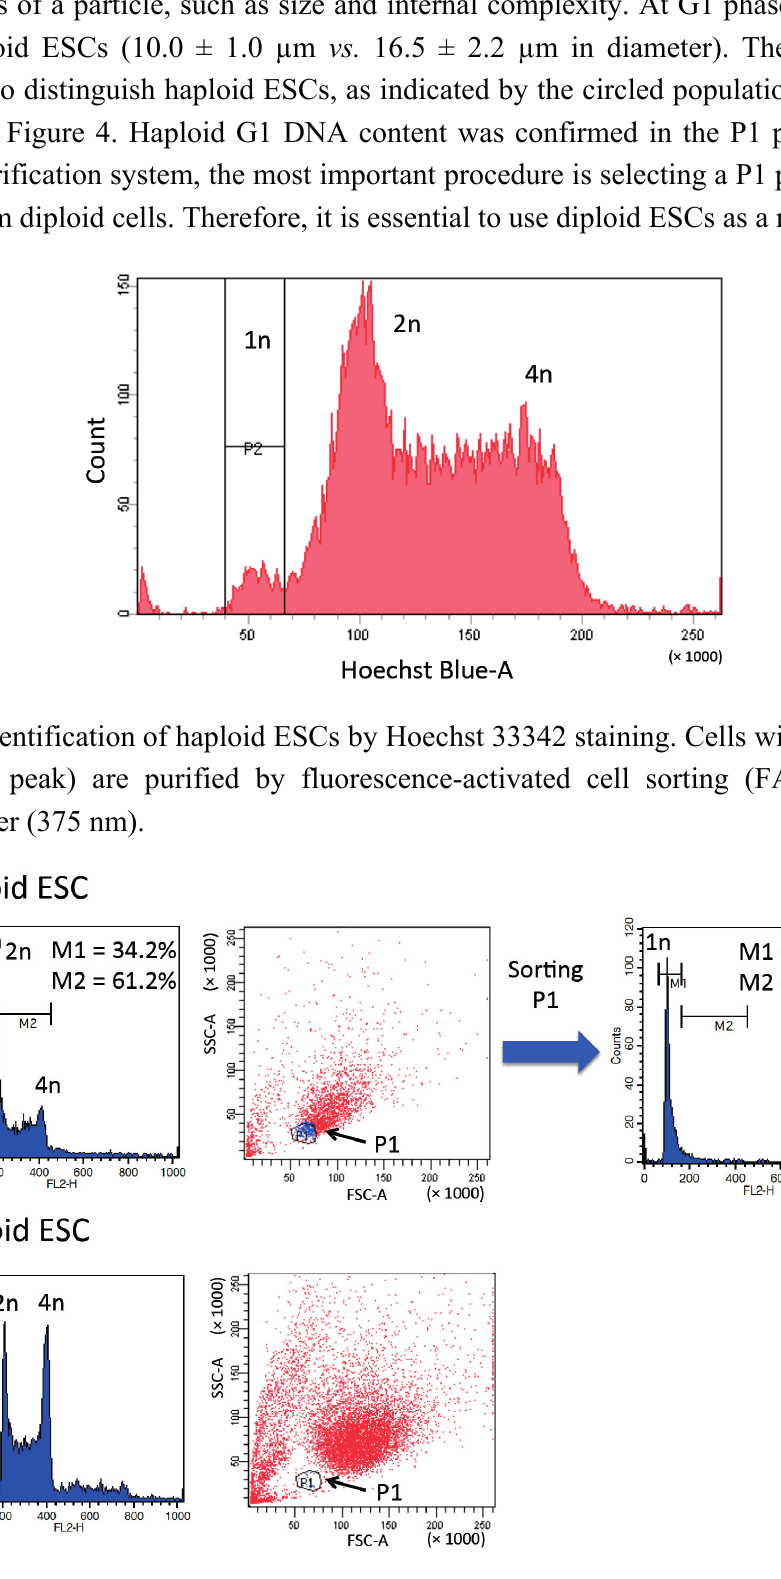
Figure 4. Purification of 1n peak of haploid ESCs using a forward scatter (FSC)/side scatter (SSC) scatter plot to determine cell size. Propidium iodide staining after fixation confirmed that population 1 (P1) contained haploid G1 ESCs and that the P1 population was largely absent in diploid